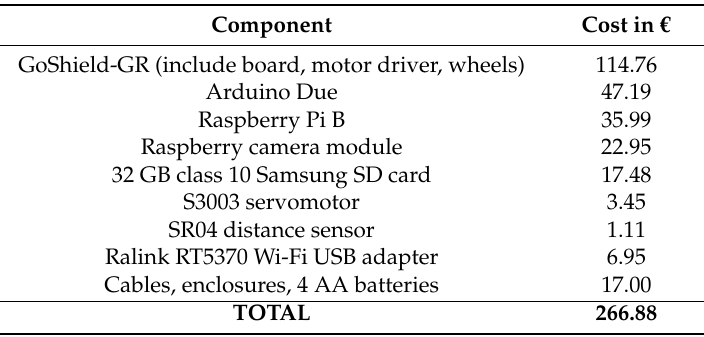
Table 1. The components of Charlie and their cost (September